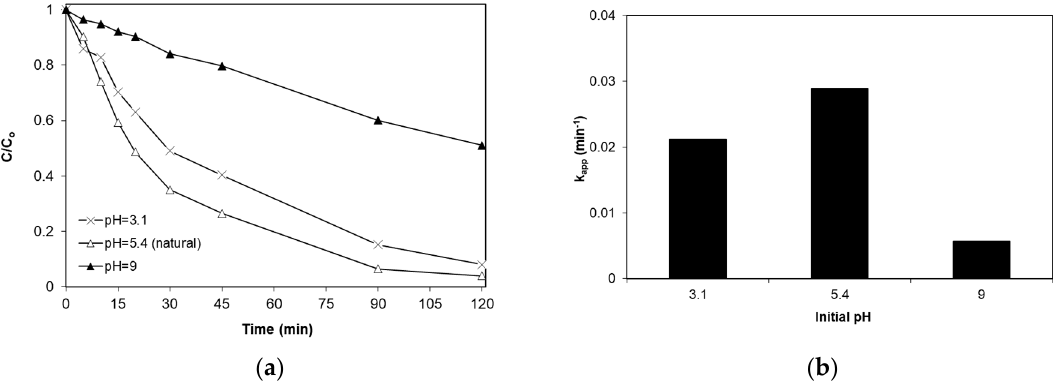
Figure 8. Effect of initial solution pH on the photocatalytic degradation of SMX in UPW ( a ) and apparent kinetic constants ( b ). [SMX] = 234 μ g/L, [0.04%Fe/TiO 2 ] = 1 g/L.